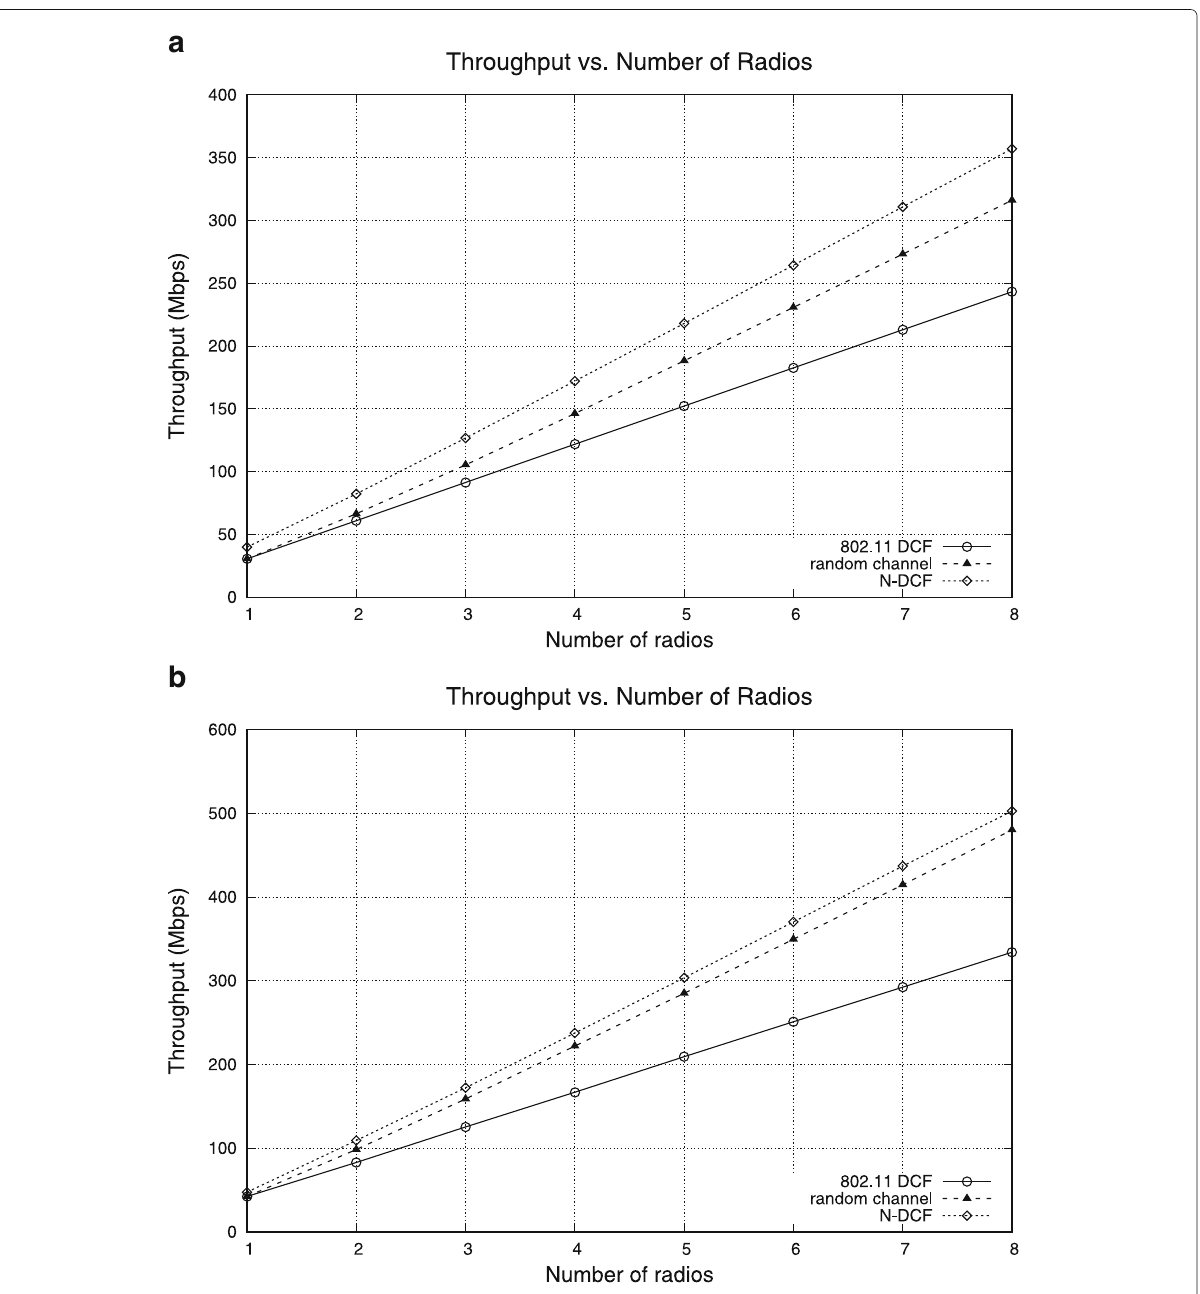
Fig. 12 Average throughput varying number of radios. a A-MPDU size = 3000 bytes. b A-MPDU size = 65,535 bytes